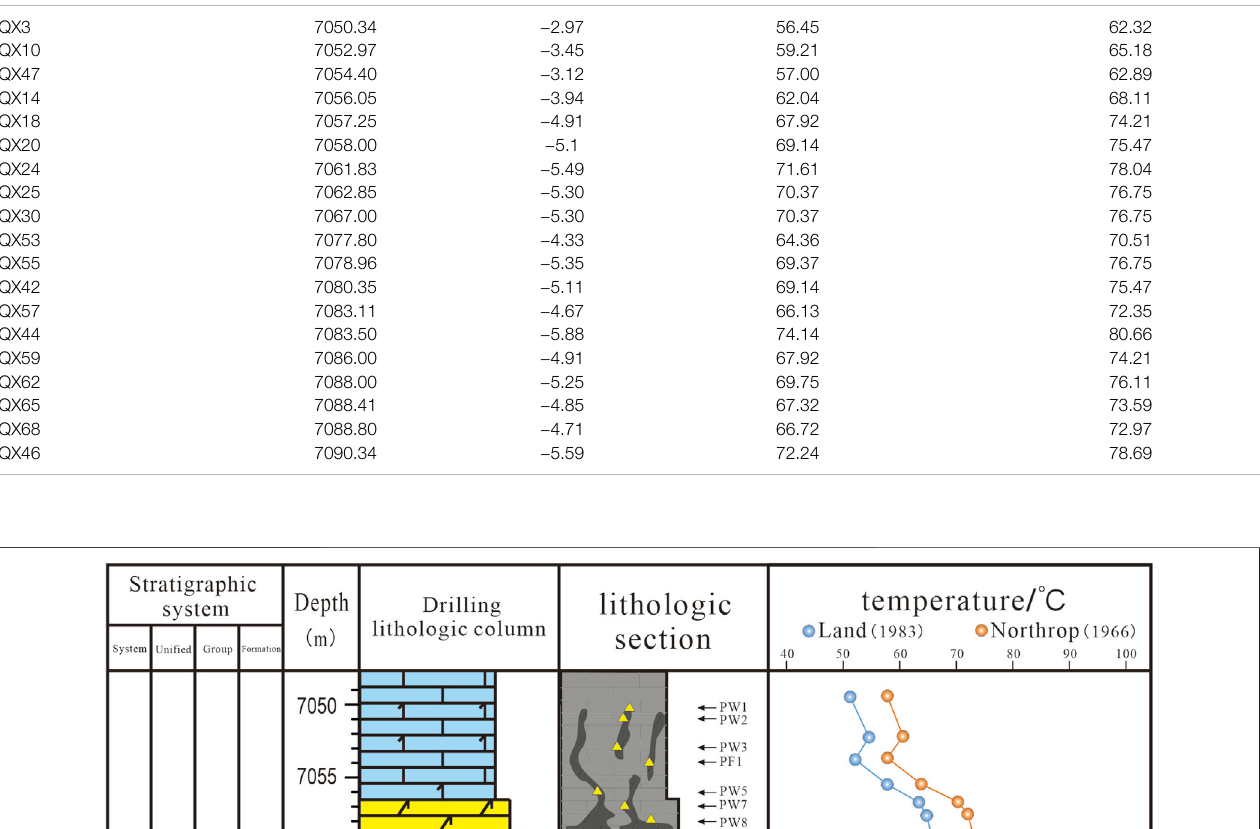
TABLE 4 | Calculated results of the diagenetic temperature of dolomites of the Qixia Formation. Number of samples Depth (m)